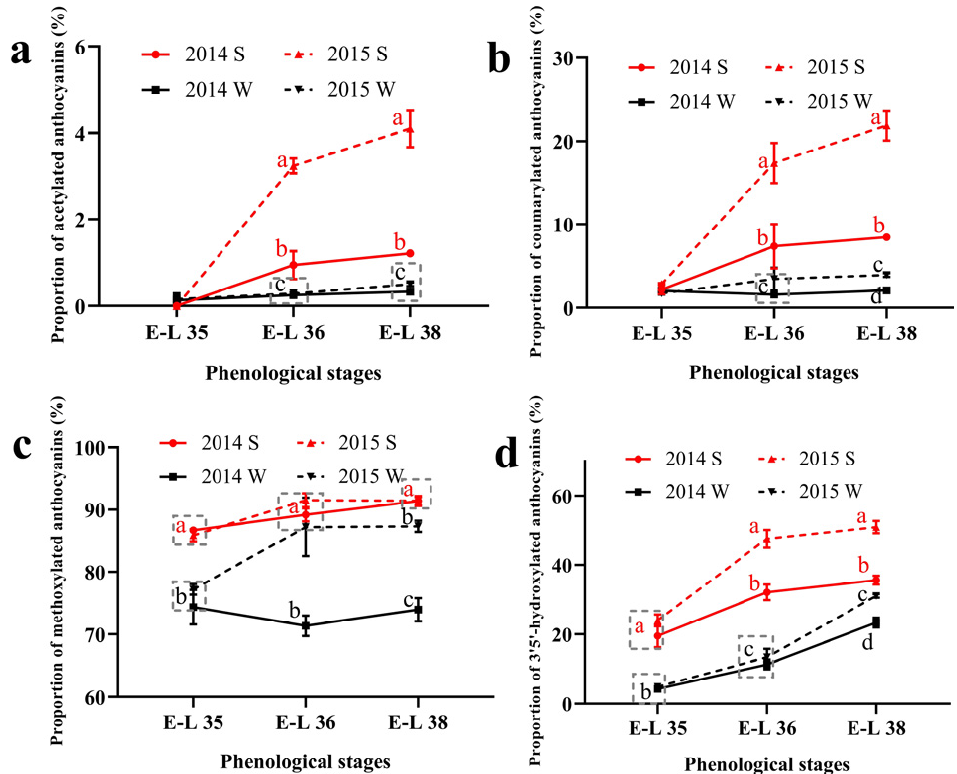
Figure 1. The proportion of acylated ( a ), coumarylated ( b ), methylated ( c ), and 3 ′ 5 ′ -hydroxylated ( d ) anthocyanins in Muscat Hamburg grape in 2014 and 2015 under the double cropping system. Different letters within the same development stage indicate significant differences among seasons (Duncan’s multiple range test at p < 0.05).